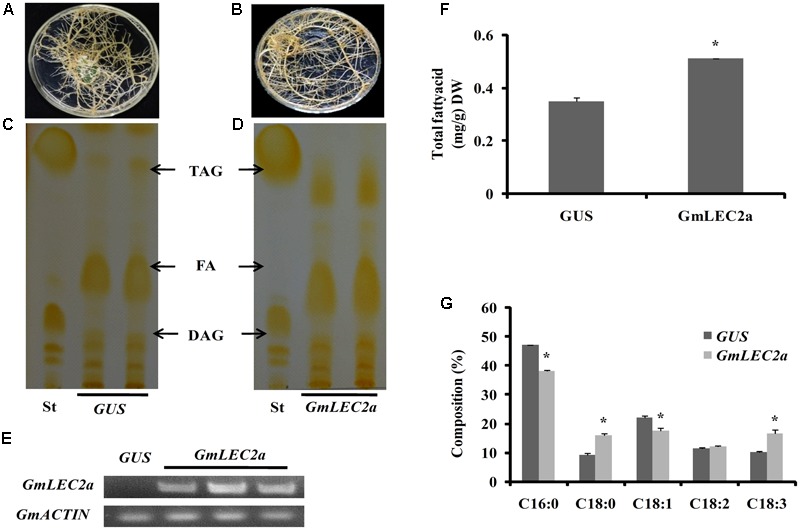
Ectopic expression of GmLEC2a in soybean hairy roots. (A,B) Hairy roots over-expressing GmLEC2a and GUS. The cotyledons of germinating soybean seeds were used for infection with Agrobacteria K599 harboring pB2GW7-GmLEC2a or GUS gene (control). The generated hairy roots over-expressing GUS
(A) and GmLEC2a
(B) were selected on MS medium containing ppt. (C,D) TLC analysis of neutral lipids extracted from hairy root over-expressing GmLEC2a
(D) and GUS control (C). (E) qRT-PCR conformation of GmLEC2a or GUS gene expression. Transcript levels are expressed relatively to that of GmACTIN.
(F,G) Comparison of TAG composition (G) and content (F) in hairy roots over-expressing GmLEC2a and GUS control grown and extracted under the identical conditions. More than 5 independent transgenic hairy root lines were analyzed. Data are from three biological replicates. All data are three biological replicates and are expressed as means ± SD. ∗∗P < 0.01 and ∗P < 0.05 by Student’s t-test (n = 3).